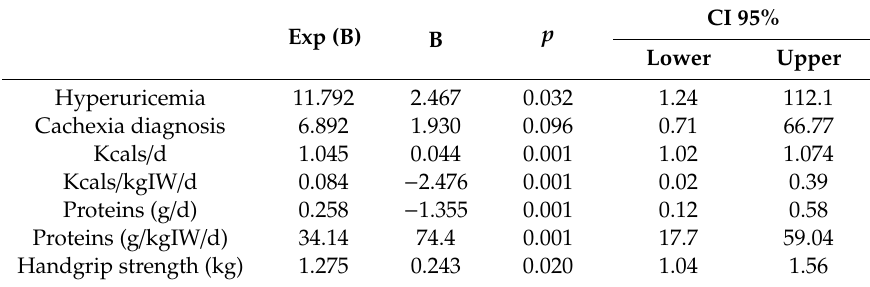
Table5. Associationbetweenuricacidandnutritionalstatusforalbumin ≥ 3.5g / dLinhemodialysispatients.